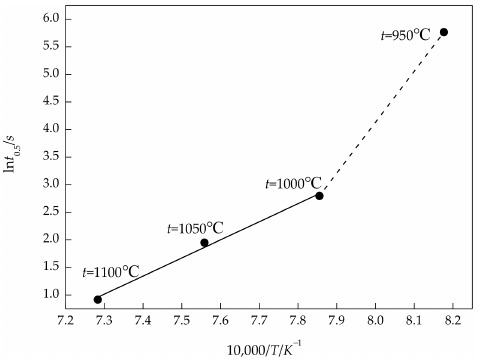
Figure 4. Relation between ln t 0.5 and 1/ T of experimental steel.